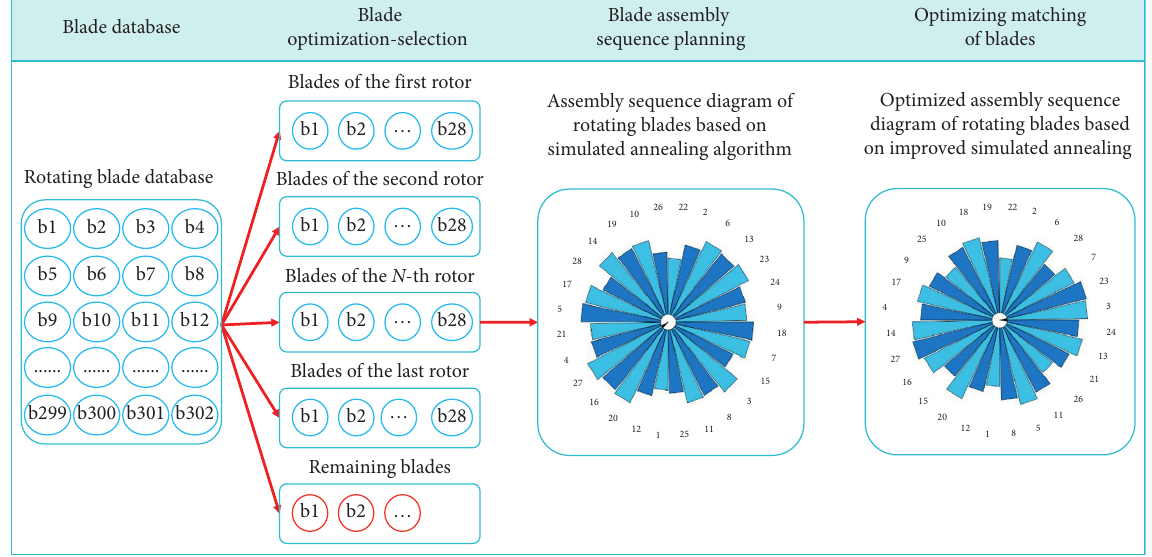
Figure 1: The framework of optimizing selection and optimizing matching of rotating blades. Table 1: The rotating blade database of the first-stage fan rotor.